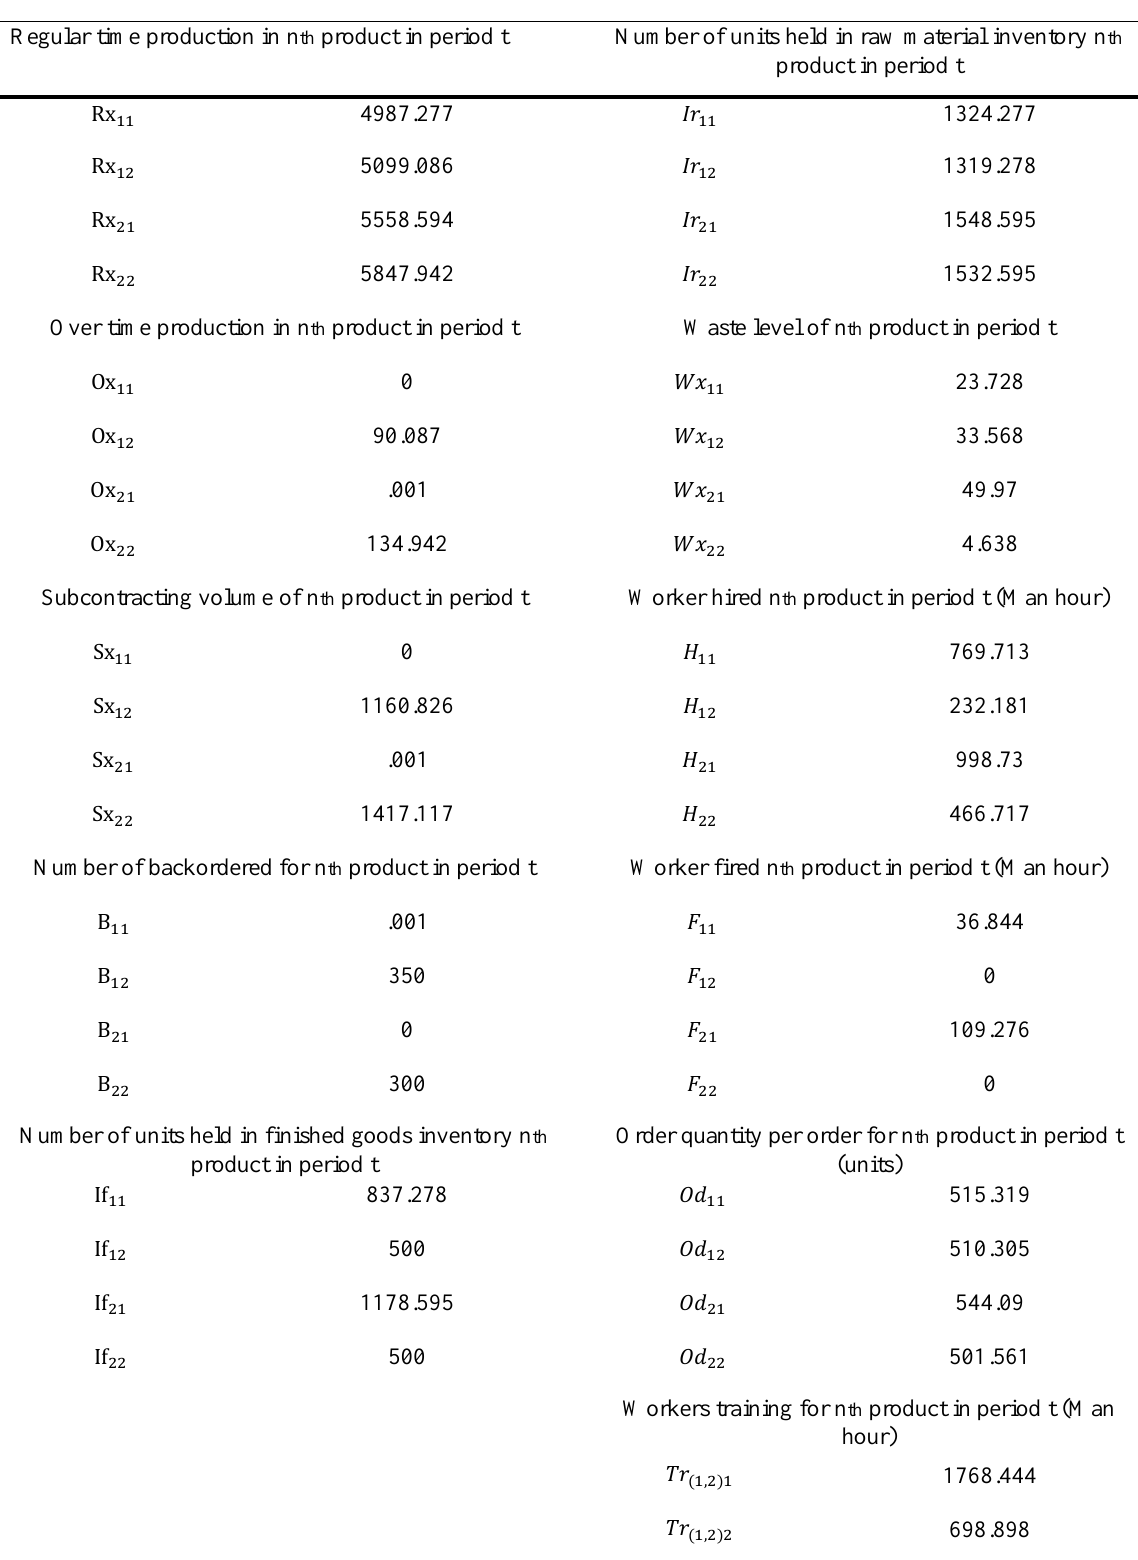
Table 6. Outputs of multi-product & multi-period APP plan for the case study (scenario